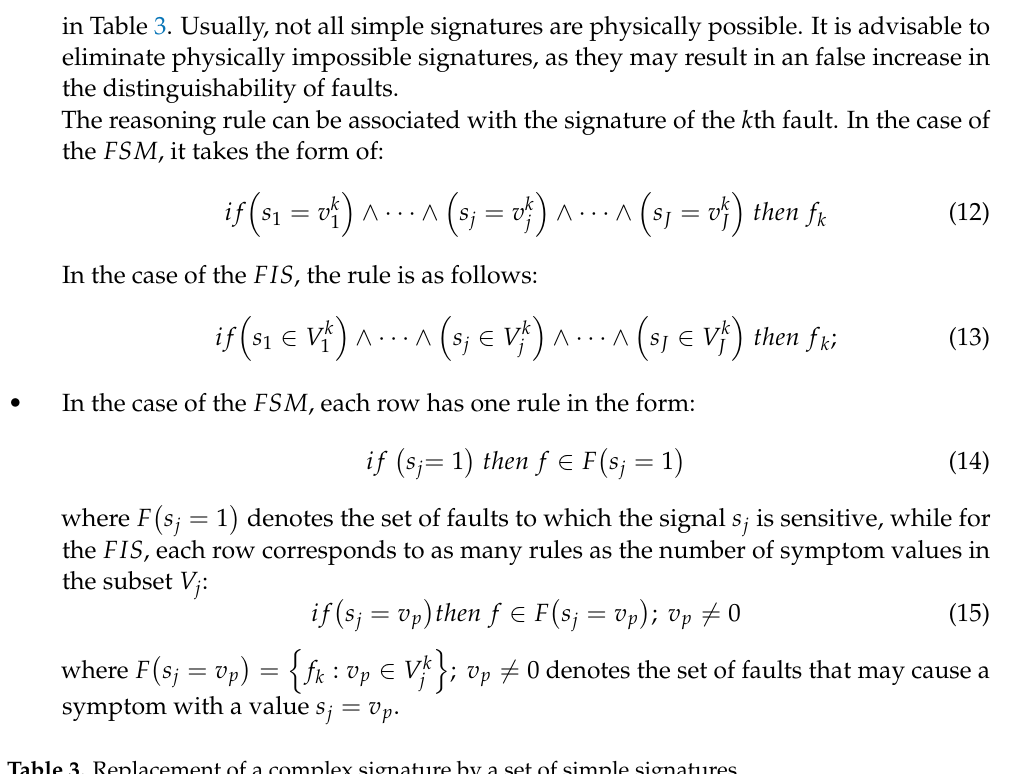
Table 3. Replacement of a complex signature by a set of simple